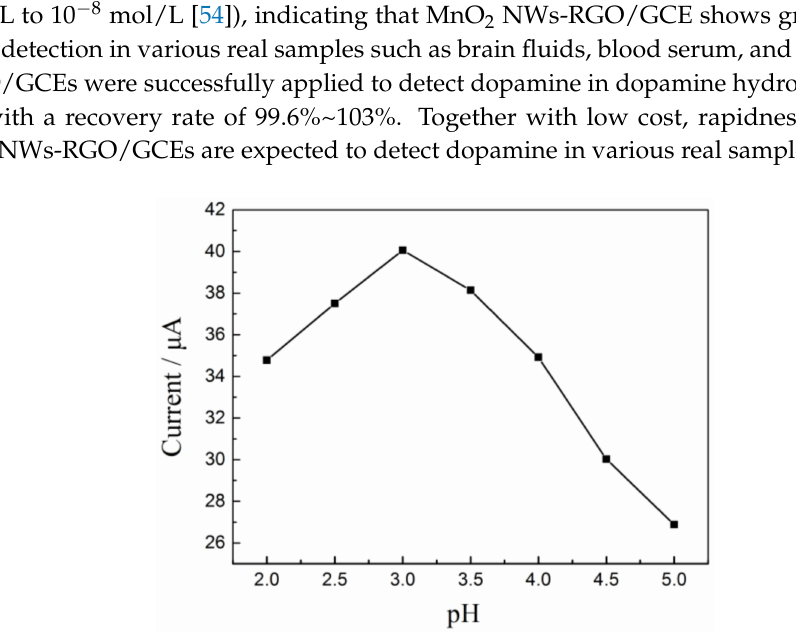
Figure 6. Effect of pH on the response peak current of 1 × 10 − 5 mol/L dopamine on the MnO 2 NWs-RGO/GCE. Table 2. Comparison of the electrochemical sensing performances between the MnO 2 NWs-RGO/GCE and previous